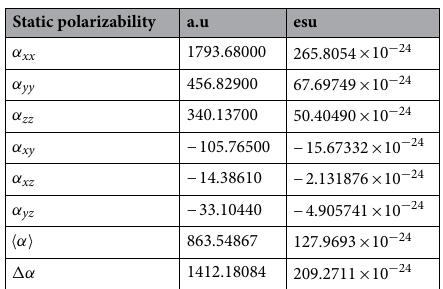
Table 5. Static polarizability tensor of Lycopene calculated using DFT at B3LYP/6–311 level of theory in a.u. unit and converted values to esu.